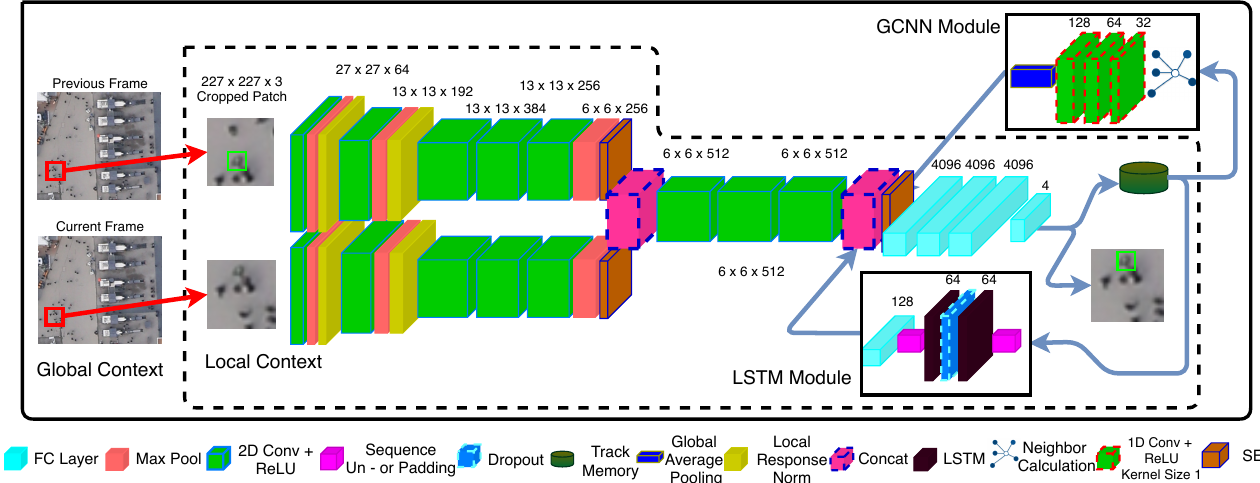
Figure 12. Overview of the network’s architecture composing a SNN, a LSTM and a GraphCNN module. The inputs are two consecutive images cropped and centered to a target object, while the output is the object location in search crop